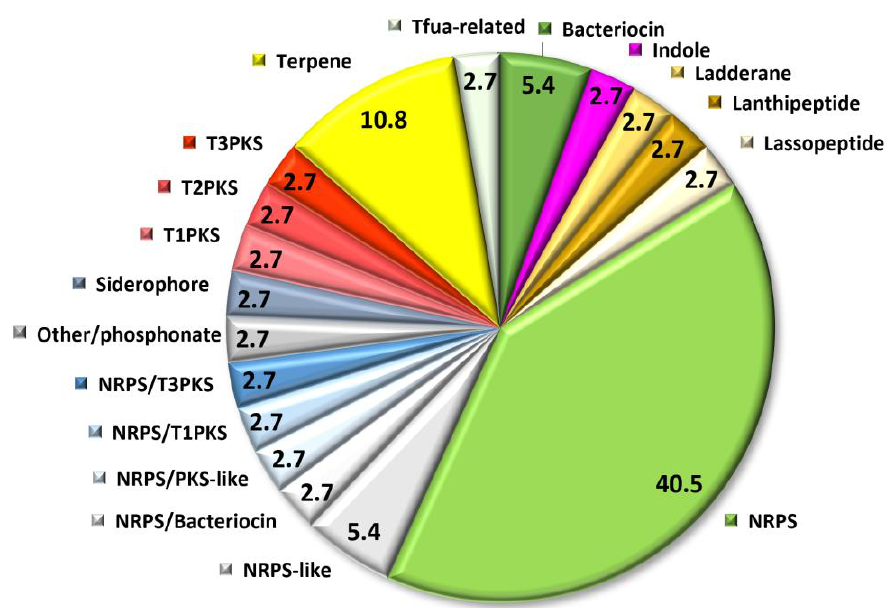
Figure 3. Main groups of biosynthetic gene clusters detected in Plantactinospora sp. S1510 T . NRPS (Non-ribosomal peptide synthetases); PKS (Poliketyde synthases), T1, T2, and T3 correspond to different types of PKS); tfua-related (Thioamitide ribosomally synthesised and post-translationally modified peptide products (RiPPs)). Values indicate the percentage of genes corresponding to each category.